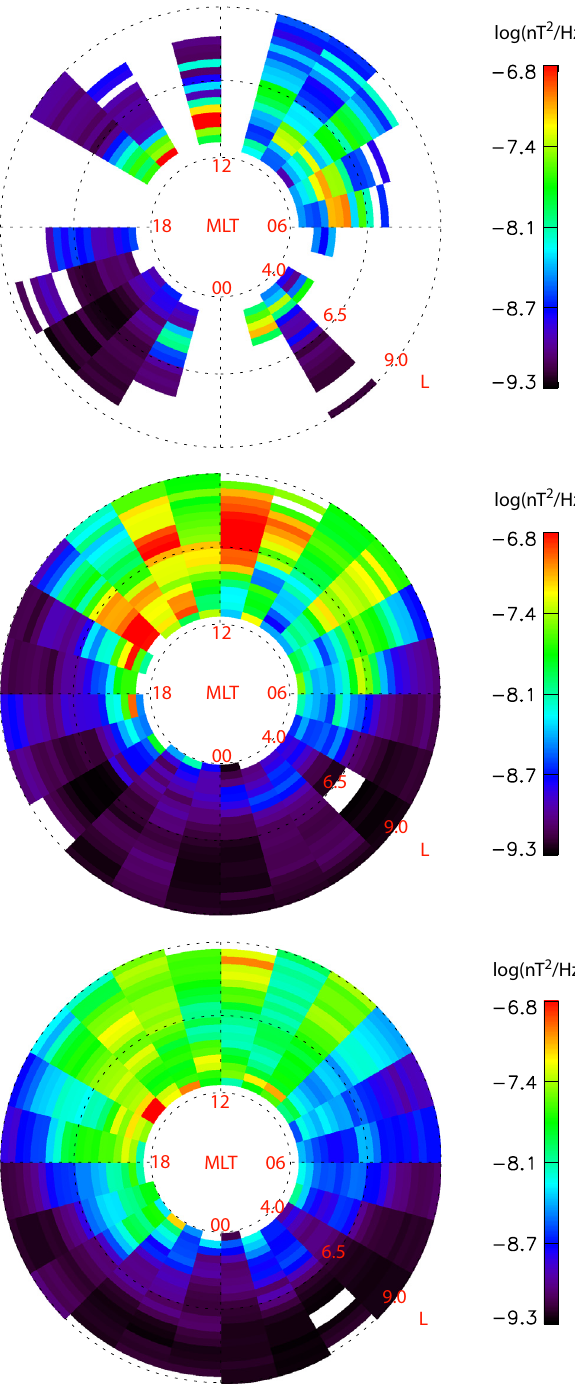
Fig. 6. Distributions of the spectral density in the frequency range 0 . 02 ≤ f/f ce < 0 . 1 (plasmaspheric hiss) for different K p lev- els. Top, central, and bottom panel corresponds, respectively, to high ( K p ≥ 5o), moderate (3o ≤ K p < 5o), and low ( K p < 3o) levels of magnetospheric